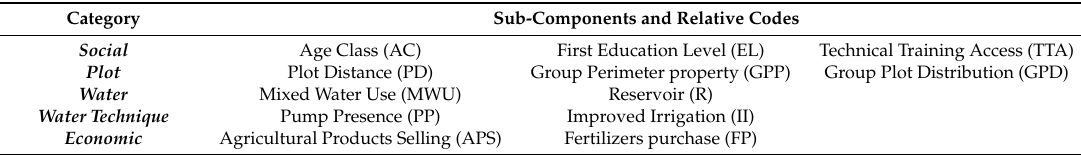
Table 2. The categories of indicators and their